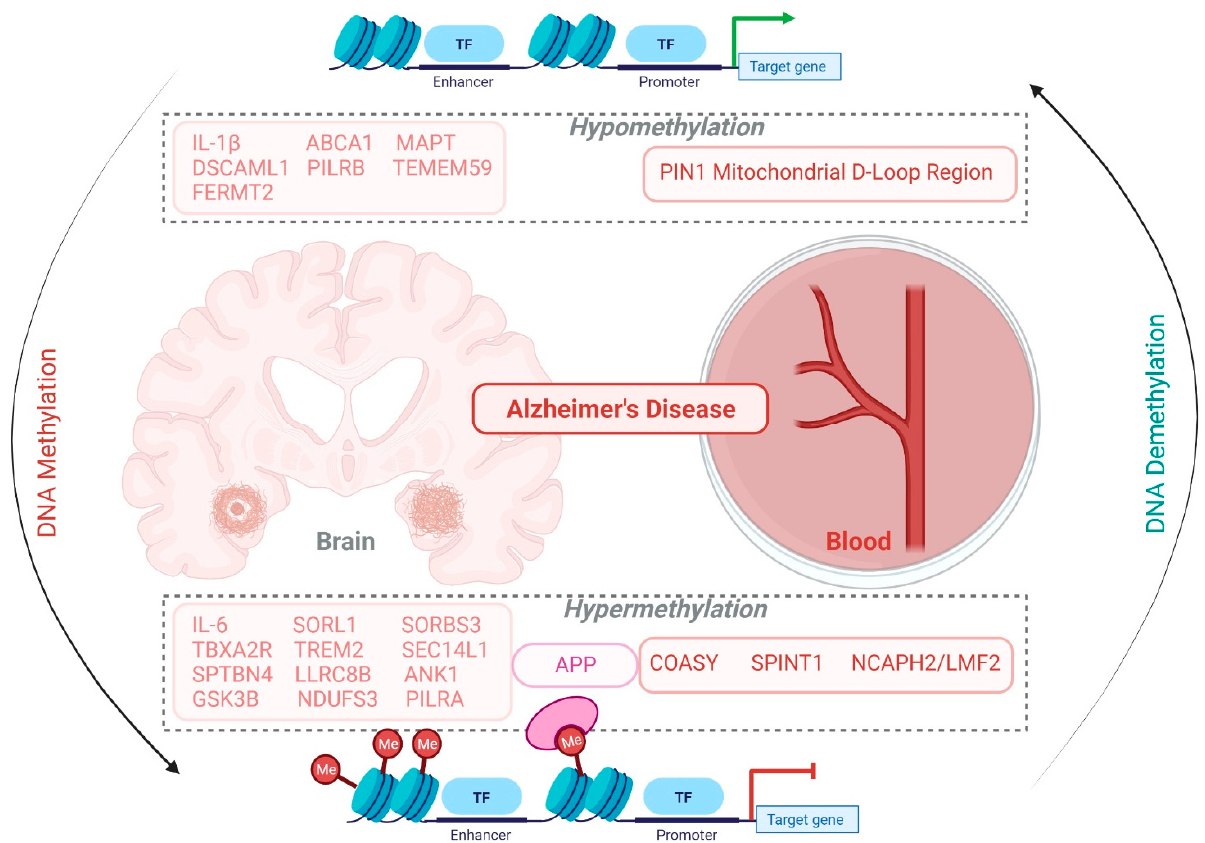
Figure 3. Differential methylation pattern of various genes in brain and peripheral blood in Alzheimer’s disease. This image illustrates the alteration in the expression of different genes in the AD brain and peripheral blood circulation due to the hyper/hypomethylation of DNA. The genes encoded in light red are specific to the brain region, while the genes encoded in red color are restricted to peripheral blood circulation. In addition, hypermethylation of the APP gene is reported as a common gene in the AD brain and peripheral blood circulation.